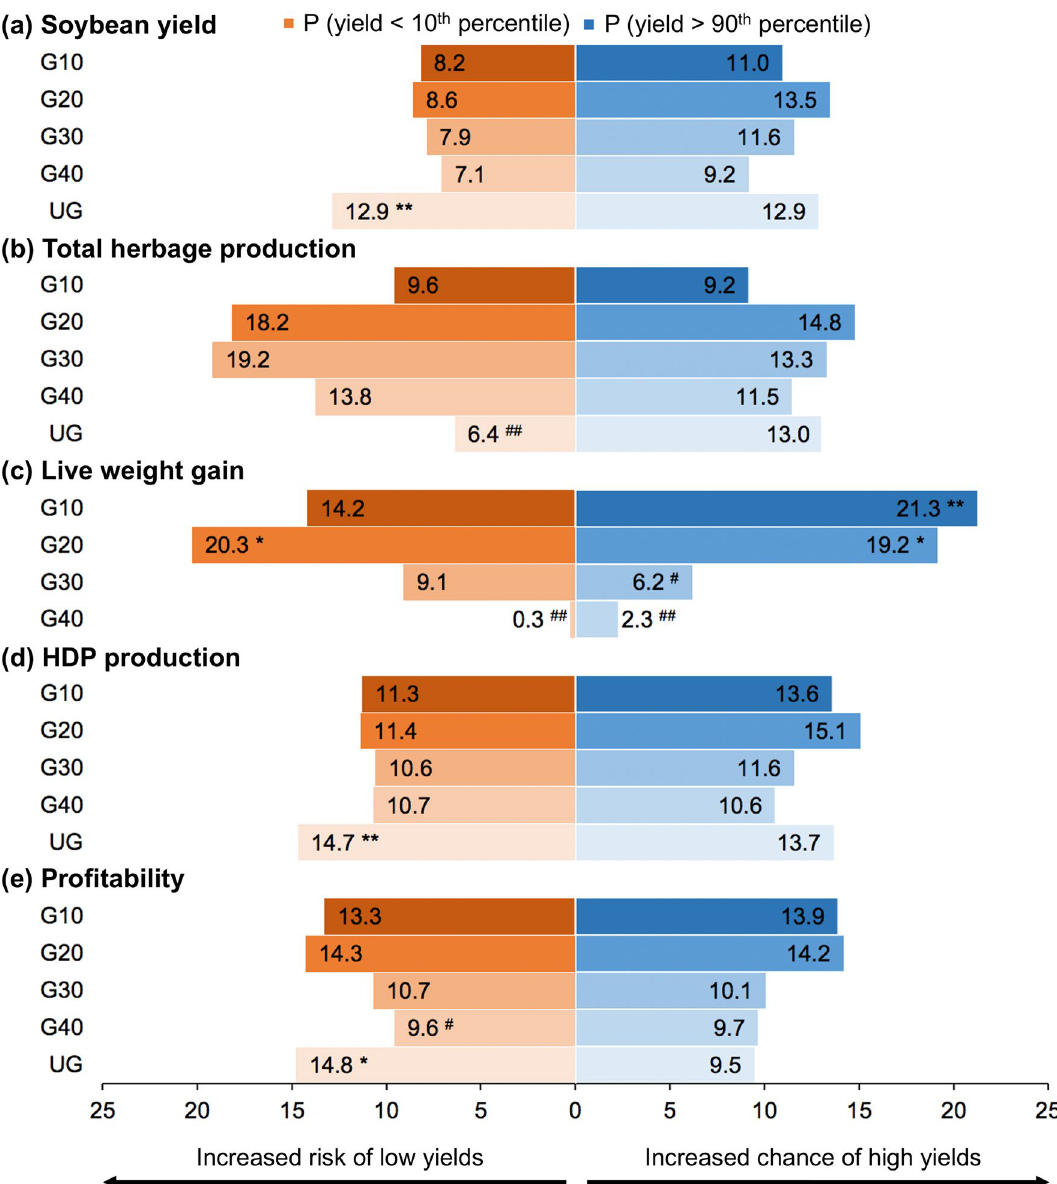
Figure 2. Effect of grazing intensity on the probability of obtaining high and low ( a ) soybean yield (kg grain ha −1 ), ( b ) total herbage production (kg dry matter ha −1 ), (c) animal live weight (LW) gain (kg LW ha −1 ), ( d ) human-digestible protein (HDP) production (kg HDP ha −1 ) and ( e ) profitability (USD ha −1 ) of soybean systems integrated with different levels of cattle grazing during the winter period in southern Brazil. Shown are the probabilities of yielding below the 10th percentile (orange bars) or above the 90th percentile (blue bars). Statistically significant treatment effect was identified for higher probability of high/low yields at the 95% (*) or 99% (**) confidence level and for lower probability of high/low yields at the 95% ( # ) or 99% ( ## ) confidence level. G10: intense grazing (10 cm sward height); G20: moderate grazing (20 cm sward height); G30: moderate-light grazing (30 cm sward height); G40: light grazing (40 cm sward height); UG: ungrazed cover represent the ability of a system to avoid crop failure or financial loss under stressful environmental conditions 44 . That said, livestock integration increased system resistance to financial loss by 81% in the lightest grazing inten- sity (G40) and up to 188% in the highest grazing intensity (G10) compared to the ungrazed control in the harsh- est environmental conditions ( p < 0.05, Table 2). Despite minimum HDP production not being significantly different among treatments, it was 55% greater in grazed treatments compared to UG and up to 69% greater than UG in the highest grazing intensity. Conversely, UG presented a lower risk of low herbage production ( ⍺ = 0.01, Fig. 2b) despite no statistical dif- ferences in minimum yield potential (Table 2). G20 and G30 had higher probability of low herbage production (18 and 19%, respectively), but were not different from the random distribution ( ⍺ = 0.05, Fig. 2b). G20 prob- ability of low live weight gain was significantly higher ( ⍺ = 0.05). G40 presented significantly lower downside